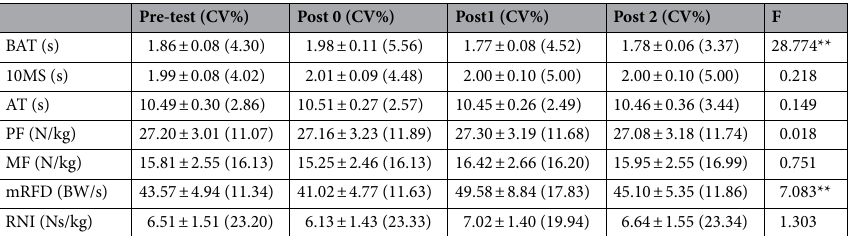
Table 1. One-way ANOVA results of the tests measured at various time points after the vibration intervention (mean ± SD). BW = body weight, BAT = blocking agility test, 10MS = 10 m sprint, AT = agility T-test, PF = peak force, MF = mean force, mRFD = maximum rate of force development, RNI = relative net impulse, CV = coefficient of variation. * p < .05, ** p <